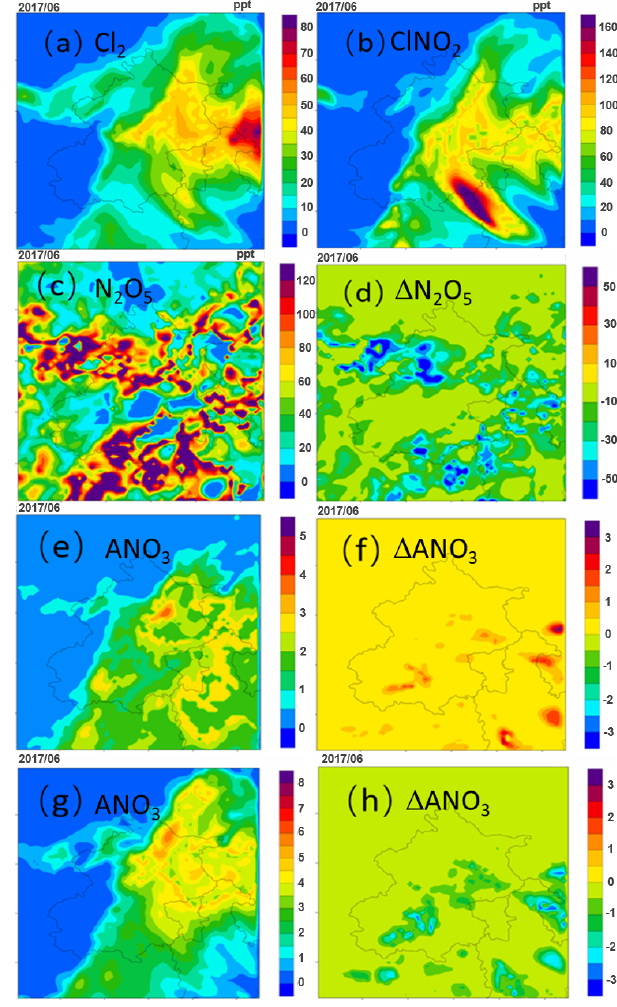
Figure 3. Spatial distributions of episode-average (a) Cl 2 , (b) ClNO 2 , (c) N 2 O 5 , (e) daytime nitrate (ANO 3 ) and (g) nighttime nitrate concentrations from 11–15 June 2017, and the differences in the episode-average (d) N 2 O 5 (HET case minus BASE case), (f) daytime nitrate and (g) nighttime nitrate (units are µgm − 3